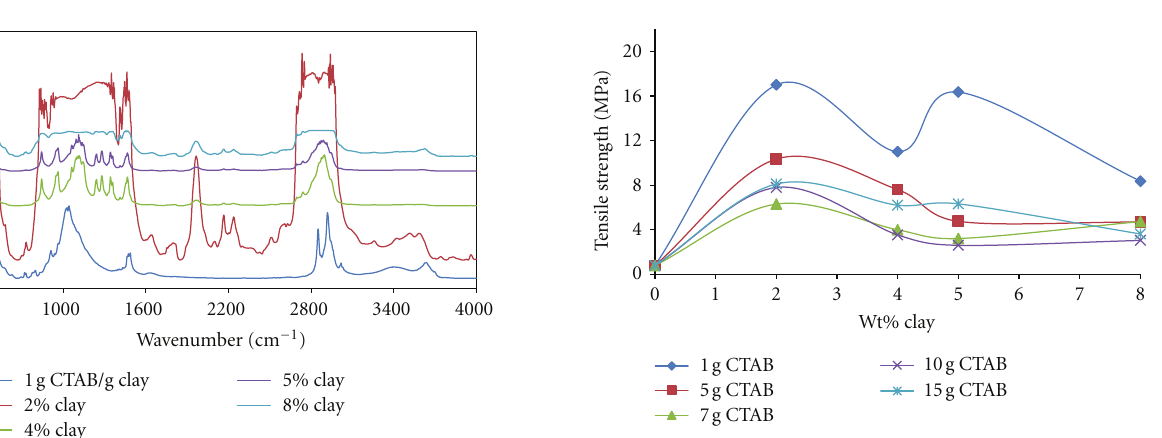
Figure 11: FTIR spectra of produced PEO/clay nanocomposites at various clay compositions (1.0g CTAB/g clay ratio).